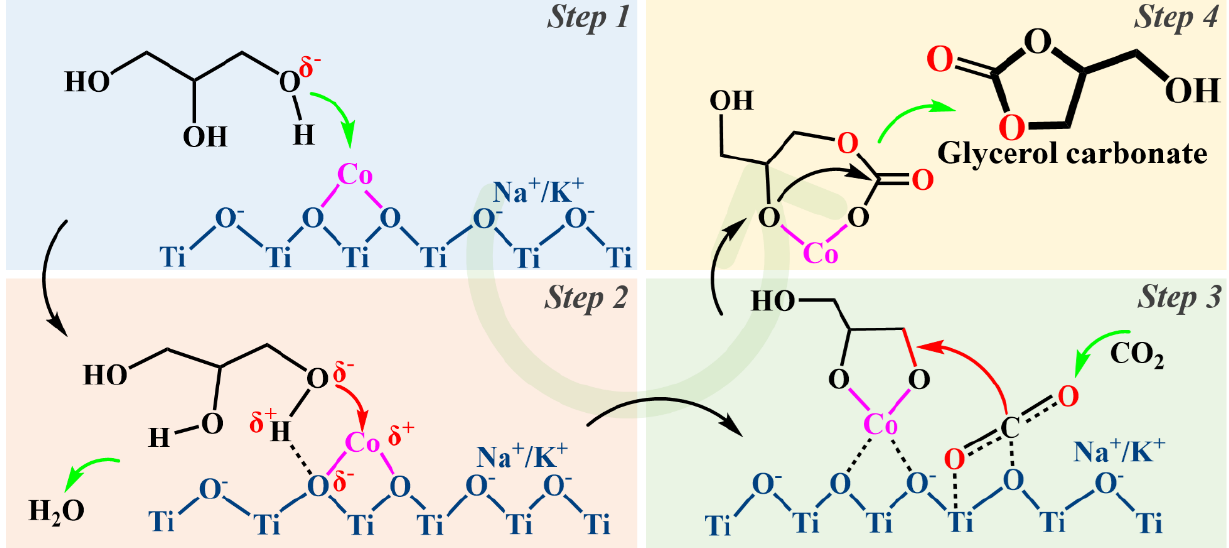
Figure 5. Stability of the Co/ETS-10 catalyst (reaction conditions: 170 °C, 4 MPa, 0.25 g catalyst, 6 h, and 5 mL CH 3 CN).